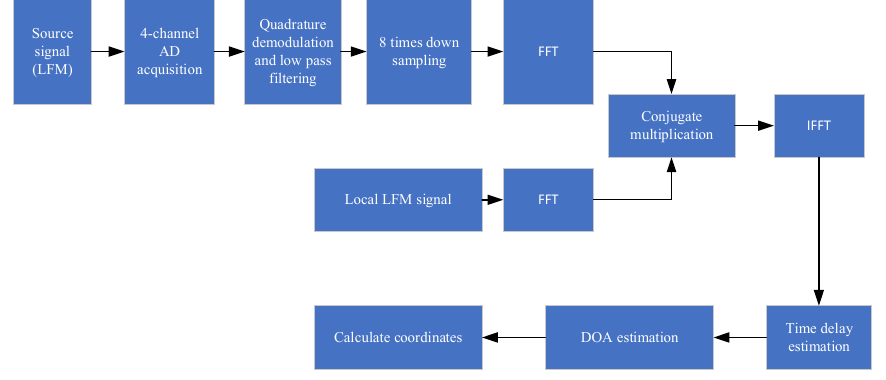
Figure 6. Algorithm processing flow.